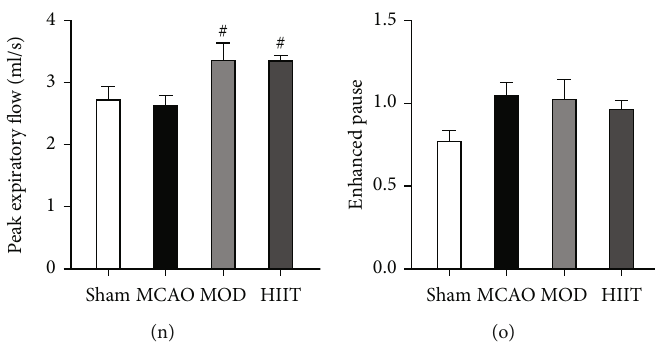
Figure 4: High-intensity interval training improved gait and pulmonary functional parameters. (a) Schematic diagram of labeled footprint and 3D footprint intensity charts. Graph demonstrates statistical di ff erences in the average run characterization parameter in each group, including stand (s) (b), swing (s) (c), duty cycle (%) (d), mean intensity (e), duration (s) (f), average speed (cm/s) (g), and cadence (step/s) (h). (i) The respiration curve illustrates the changes of volume of the plethysmograph induced by the volatility of the mouse ’ s thorax in each group. The graph demonstrates statistical di ff erences in the average pulmonary functional parameter in each group, including respiratory frequency (j), tidal volume (k), minute ventilation (mL) (l), peak inspiratory fl ow (mL/s) (m), peak expiratory fl ow (mL/s) (n), and enhanced pause (o). Values are expressed as the mean ± SEM of the mean. ∗ P < 0 : 05 and ∗∗ P < 0 : 01 compared with the sham group; # P < 0 : 05 and ## P < 0 : 01 compared with the MCAO group as determined by one-way ANOVA (Tukey ’ s multiple comparison test) for the data with normal distribution. The letters for no signi fi cance were not shown. Abbreviation: RF: right